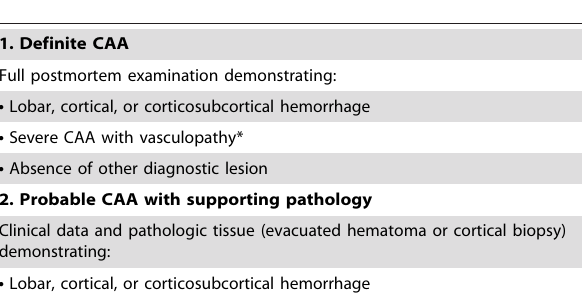
Table 1. Boston criteria for CAA